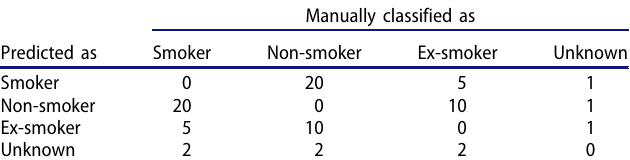
Table 3. Error cost matrix with assigned weights to each type of prediction